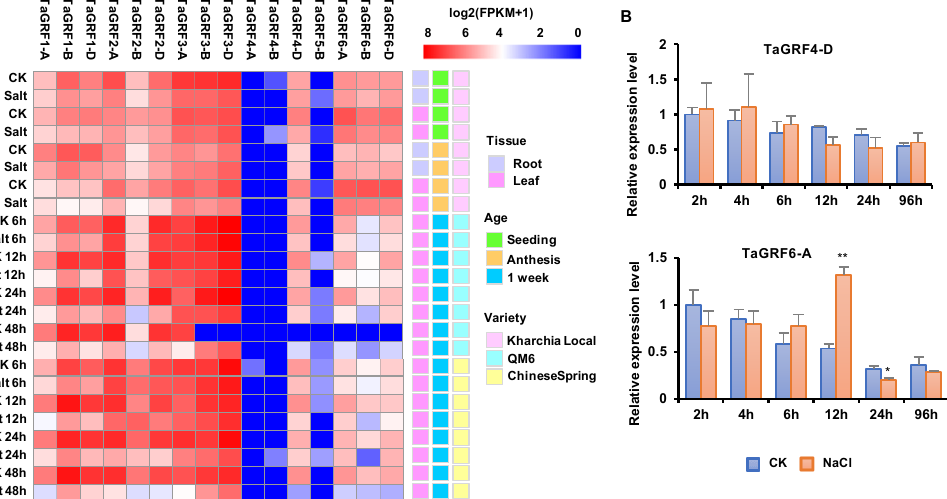
Figure 4. Expression patterns of TaGRFs . ( A ) Transcriptome analysis of TaGRFs across salt stress. The expression data were generated from NCBI and viewed in RStudio software. The relative expression level of a particular gene in each column was normalized against the mean value by log2 transformation. The color scale represents relative expression levels. ( B ) qRT-PCR analyses of two TaGRF genes in leaves under NaCl treatment. The asterisks indicate statistical significance between CK and NaCl treatments (**, p < 0.01; *, p < 0.05; Student’s t -test).